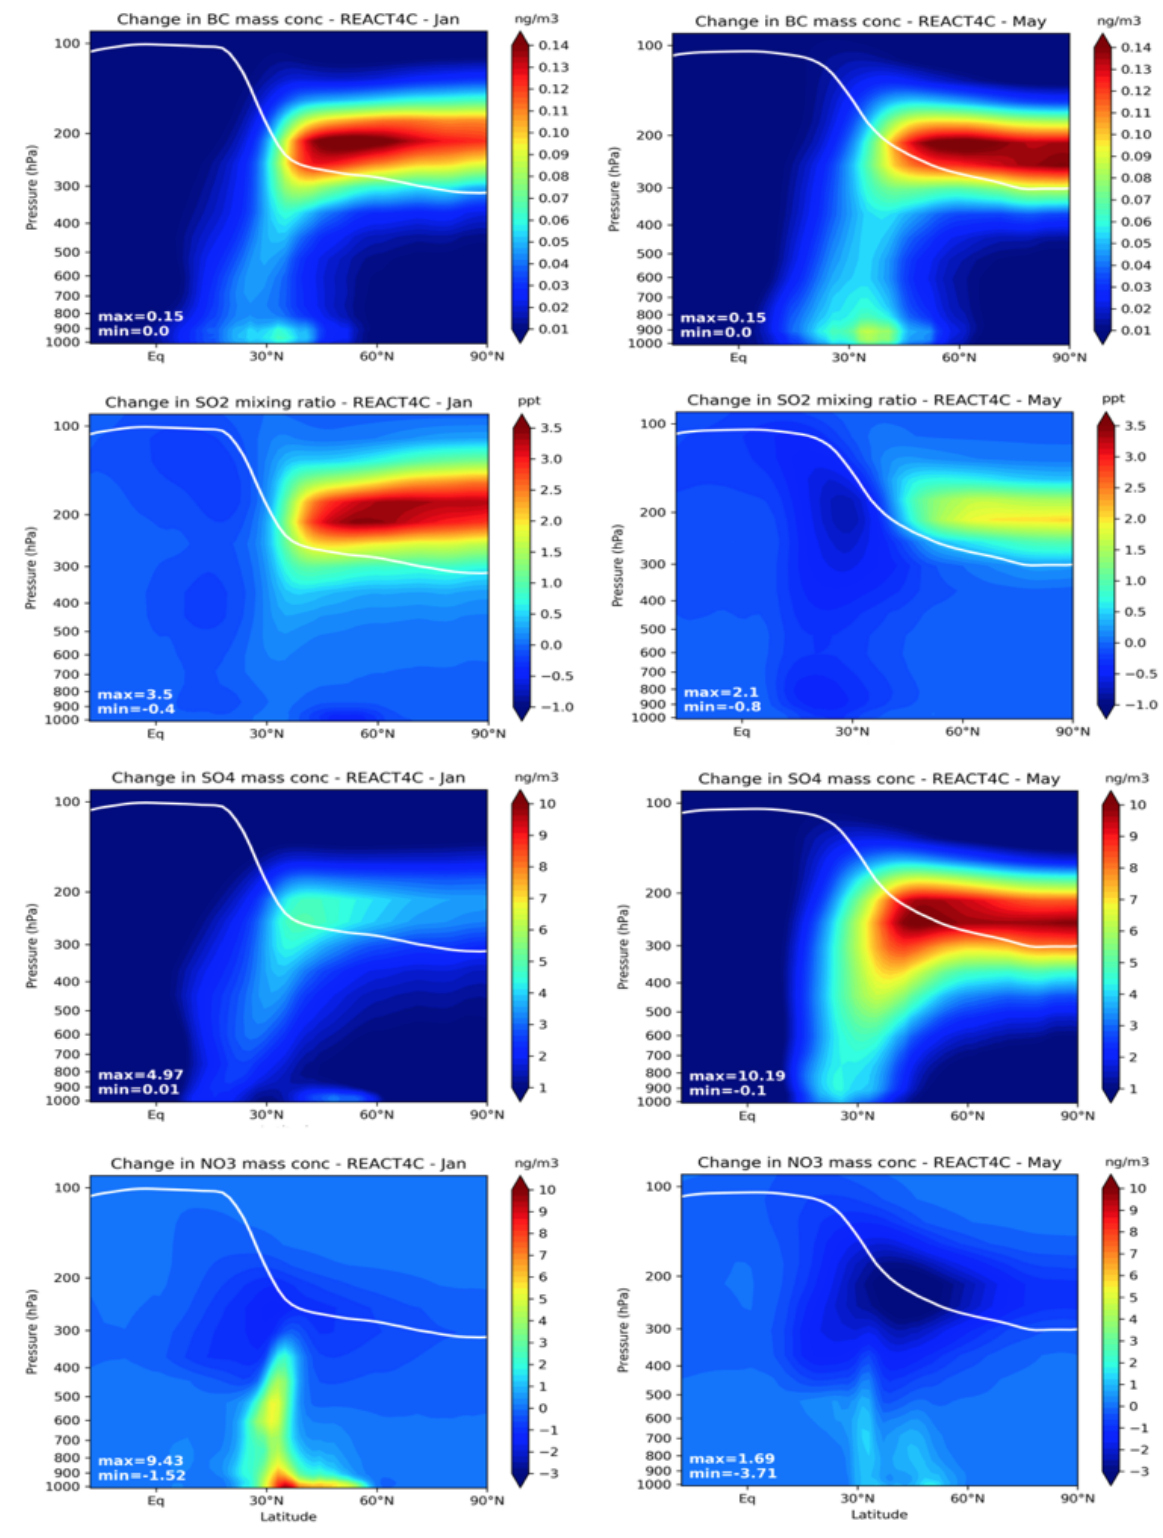
Figure 7. Zonal mean perturbations due to aircraft emissions for January (left) and May (right) of BC (ngm − 3 ), SO 2 (pptv), SO 4 (ngm − 3 ), and NO 3 (ngm − 3 ) for the REACT4C_2006 inventory. The solid line represents the tropopause pressure.